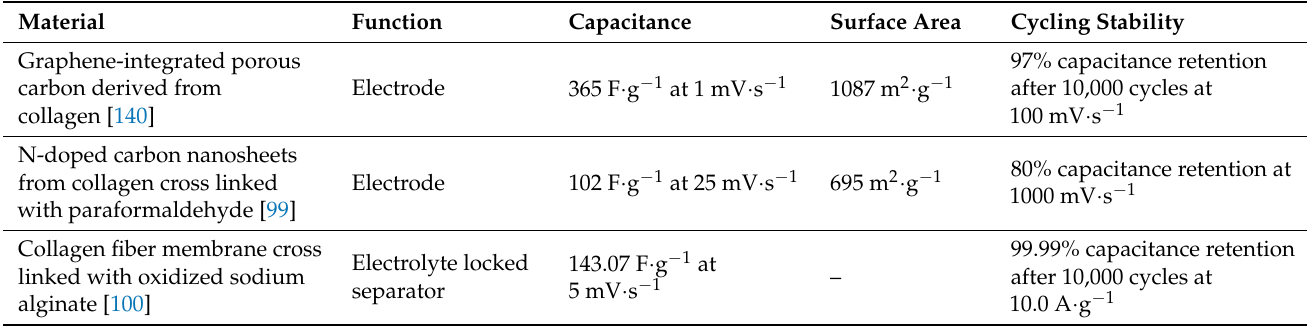
Table 4. Biopolymer applications as capacitor